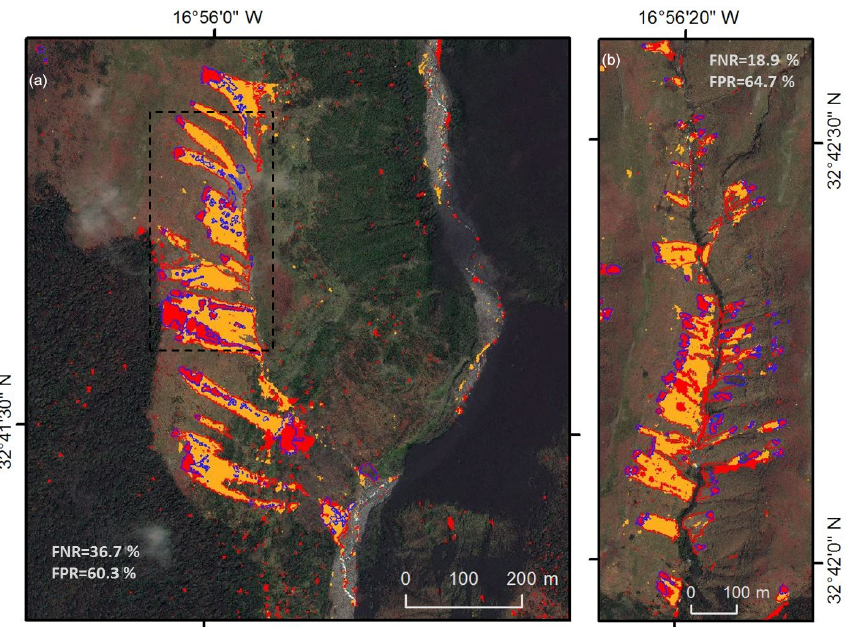
Figure 7. Classified landslide sources (red fill) and run-out (yellow fill) compared to inventory reference data (red contours delineate the landslide; blue contours delineate the source area). In the examples shown, source areas are defined either as primary sources only (in b , validation region 2) or also including secondary sources of sediment (in a , validation region 1). GeoEye-1 pan-sharpened RGB composite as base image. The area inside the dashed outline corresponds to Fig.